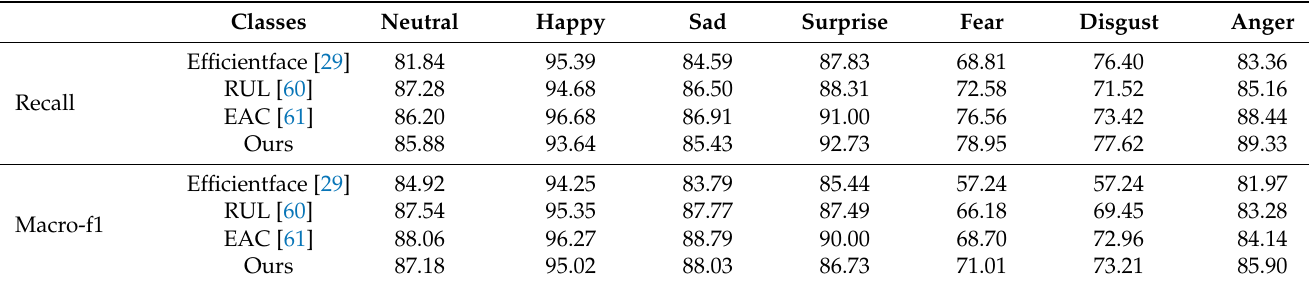
Table 3. We compare the accuracy of our algorithm for each class in the RAF-DB dataset with that of the EfficientFace algorithm, RUL, and EAC, mainly comparing the recall and macro-f1. The results in the table show that our algorithm can significantly improve the recognition accuracy of fear, disgust, and anger minority